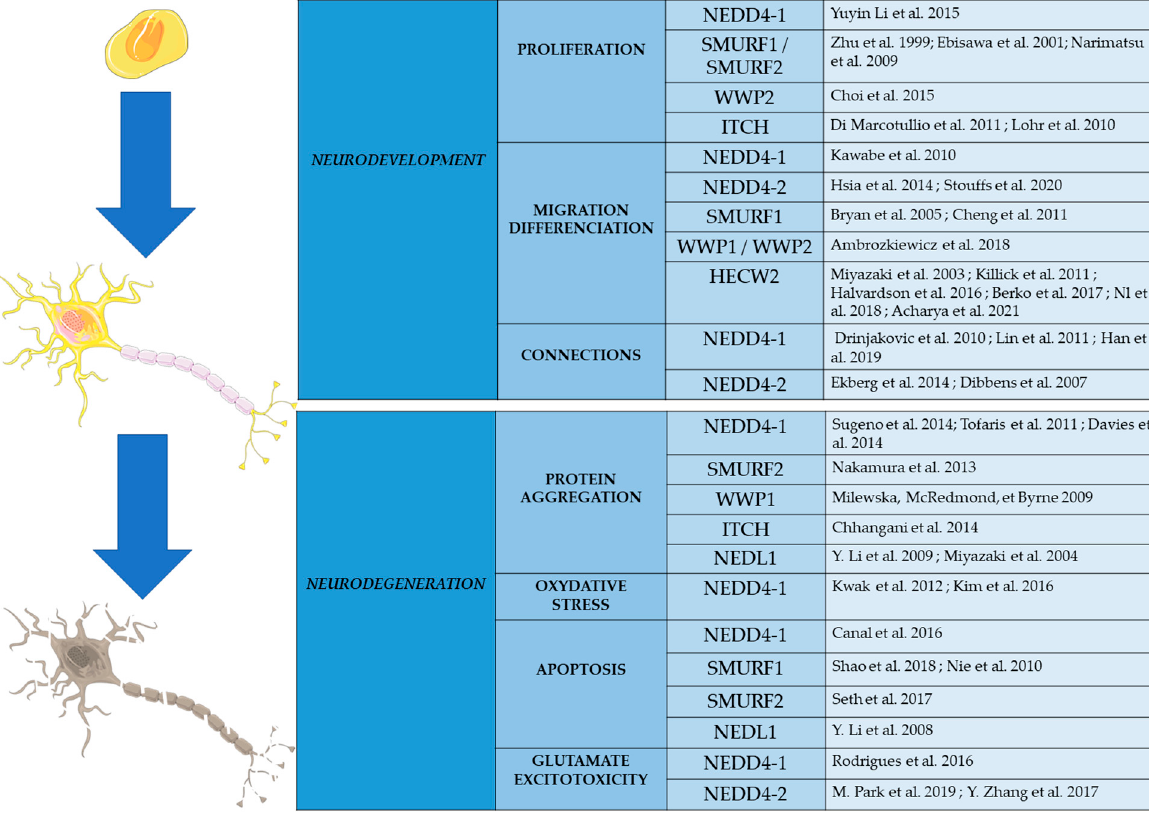
Figure 3. Schematic representation of the roles played by E3 ligases of the HECT subfamily in cellular processes involved in CNS development and neurodegeneration. Substrates of these enzymes are presented in the references.